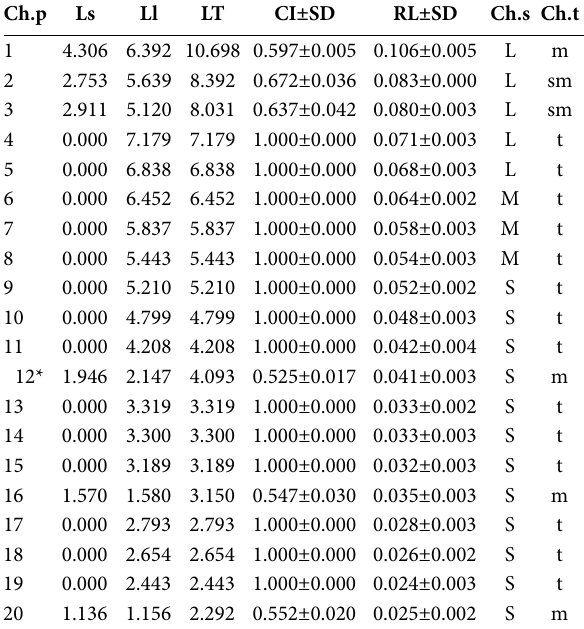
Table 1. Mean length of short arm chromosome (Ls), long arm chromosome (Ll), total chromosomes (LT), centromeric index (CI), relative length (RL) and standard deviation (SD) of CI and RL from 20 metaphases of male and female Cyrtodactylus kunyai , 2 n = 40. Ch.p